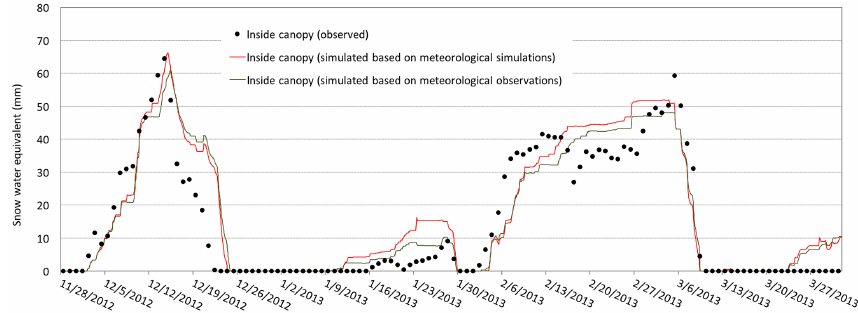
Figure 12. Simulated and observed snow water equivalent inside the forest canopy for the winter period 2012/13 at site Vordersteinwald. The two curves illustrate the snow simulations achieved with the parameterized (red) and observed (green) meteorological conditions inside the canopy.